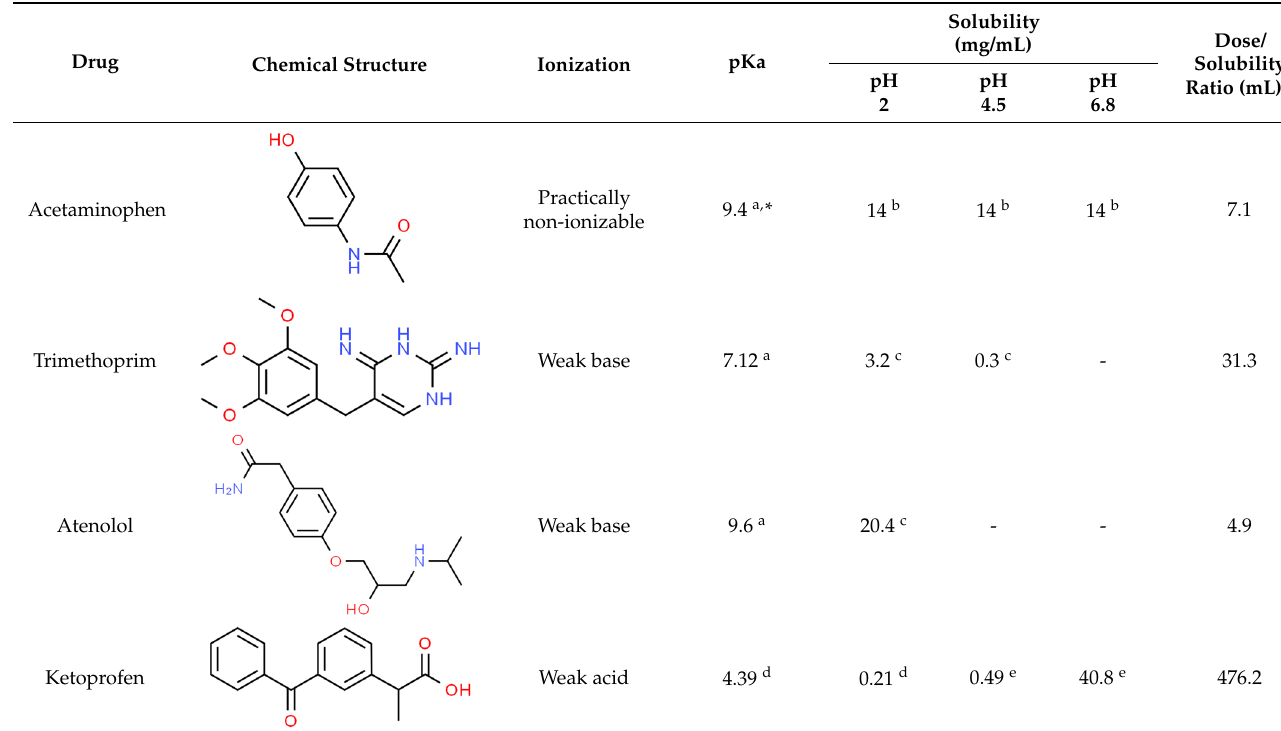
Table 1. Physicochemical properties of model drugs.